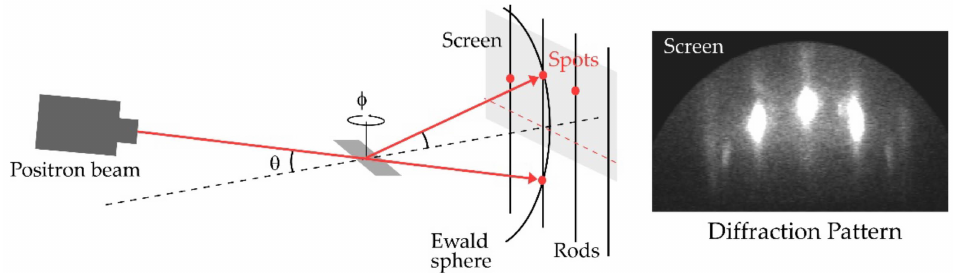
Figure 6. Schematic diagram of TRHEPD. A positron beam is incident on a sample surface with a glancing angle ( θ ) and an orientation fixed at a specific azimuthal angle ( φ ). The diffraction spots appear at the intersection of the Ewald sphere and reciprocal-lattice rods and the spots are projected onto the screen as the diffraction pattern on the